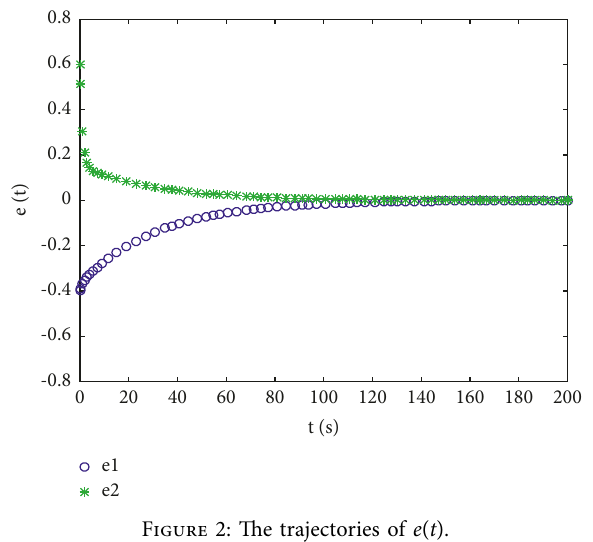
Figure 2: The trajectories of e ( t ).